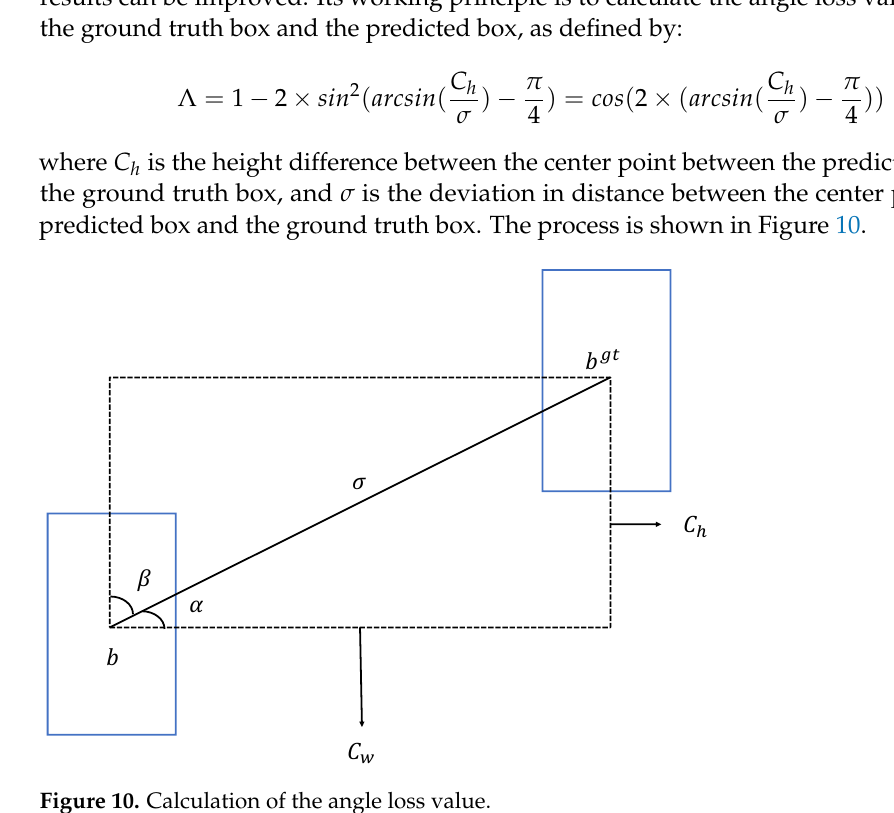
Figure 10. Calculation of the angle loss